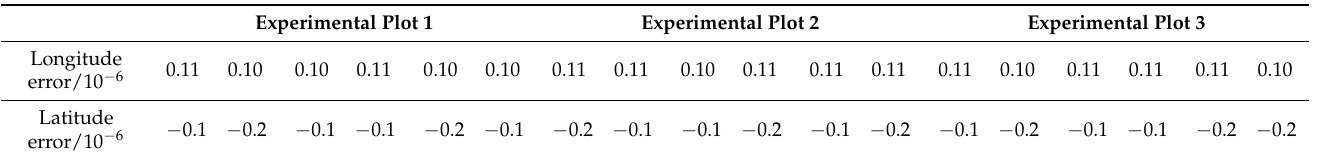
Table 6. UTM coordinate result